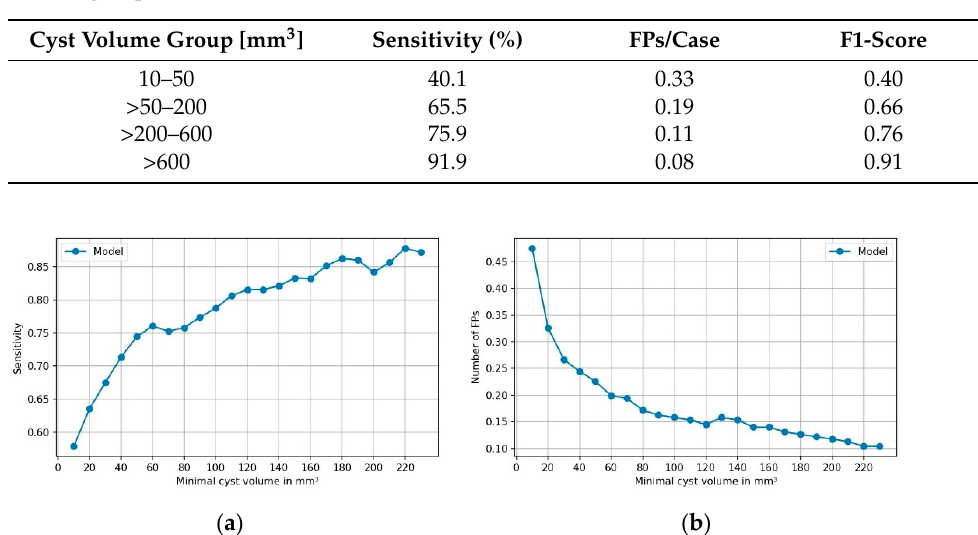
Figure 4. The ( a ) sensitivity and ( b ) FP rate of model’s predictions as a function of cyst volume. Each dot indicates the sensitivity and FP rate for cysts of equal or larger volume.